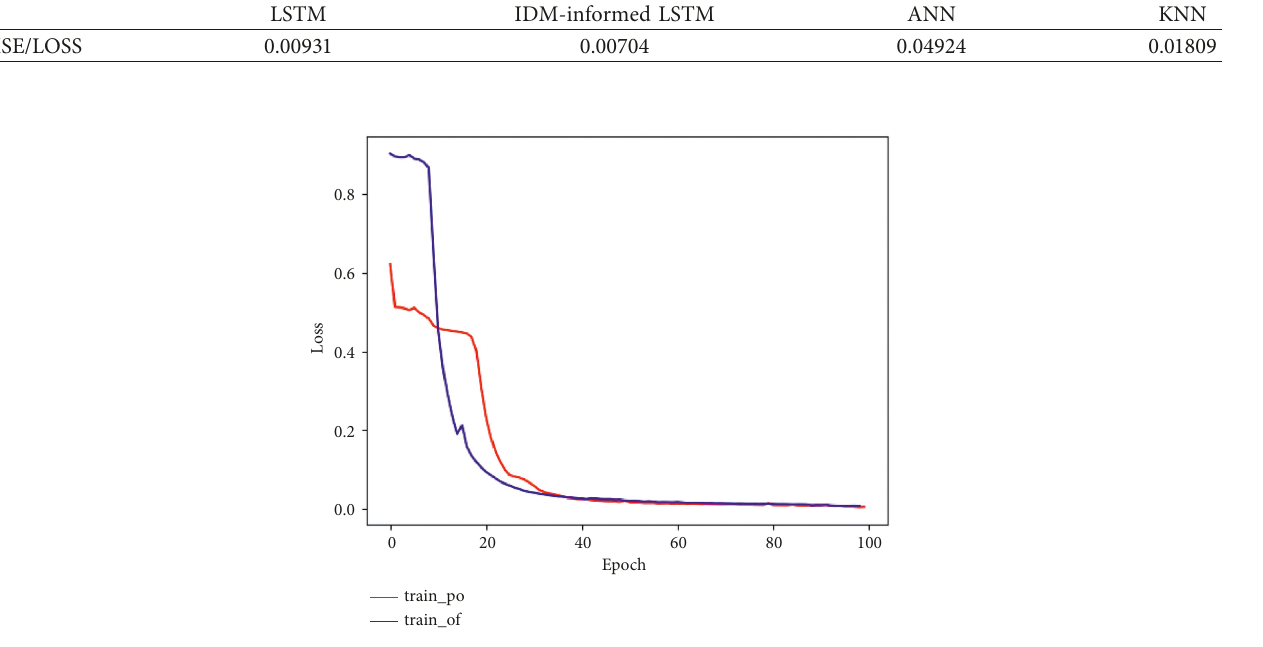
Figure 9: The train loss curves.